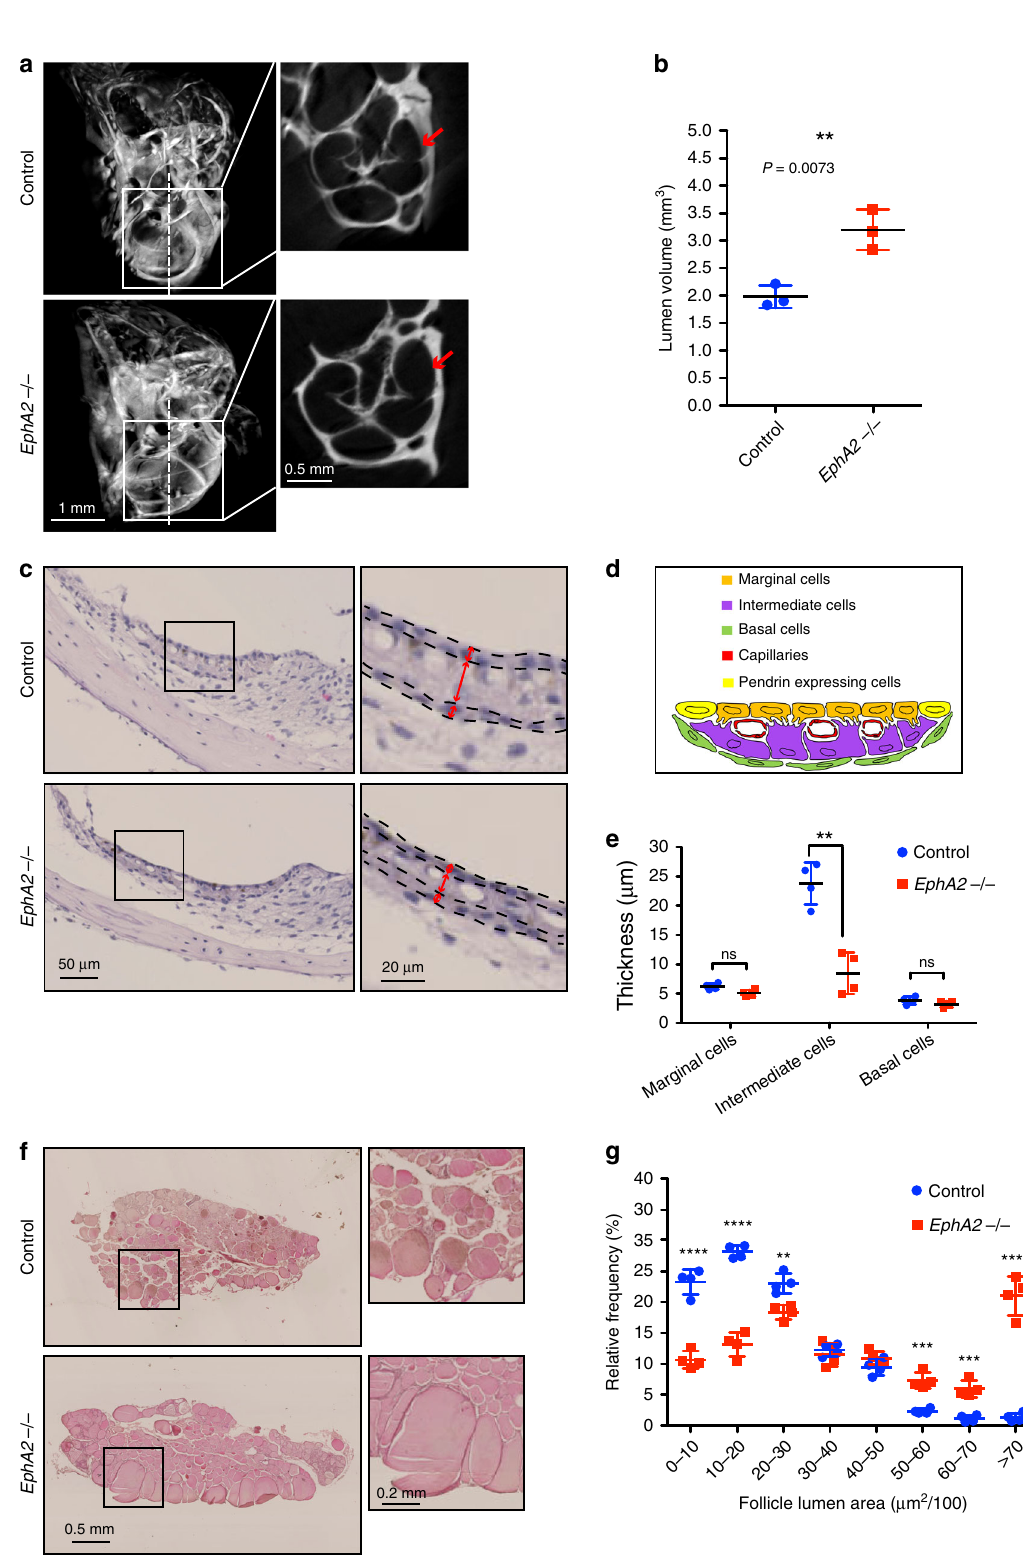
Fig. 2 Morphological analysis of EphA2 KO mice phenotype in the inner ear and thyroid. a View of the inner ear of control (upper panels) and EphA2 KO mice (lower panels) visualized by µ CT. Arrows in the sagittal section indicate the lumen in the cochlea. b Lumen volume was quanti fi ed. Lines indicate mean value from three animals with SD. ** p < 0.01 by student t -test. c – e Thickness of stria vascularis in the EphA2 KO mice was reduced compared to that in control mice. c H&E staining of the inner ear are shown. Dot-line indicates the boarder of cell layers. d SV was consisted of mainly three cell types, maginal cells, intermedia cells and basal cells as shown in (d). H&E staining of the inner ear revealed a decreased thickness of the intermedia cell layter in EphA2 KO mice. e Average data from 4 animals are presented. Lines indicate mean value from four animals with SD. ** p < 0.01 by student t -test. f , g EphA2 KO mice exhibited Thyroid goitre. H&E staining of thyroid sections are shown in ( f ). Proportion of follicle lumen area in control and EphA2 KO mice is presented in the graph ( g ). Mean ± SD.; one-way ANOVA; **** p < 0.0001, *** p < 0.001, ** p < 0.01. Source data are provided as a Source Data fi